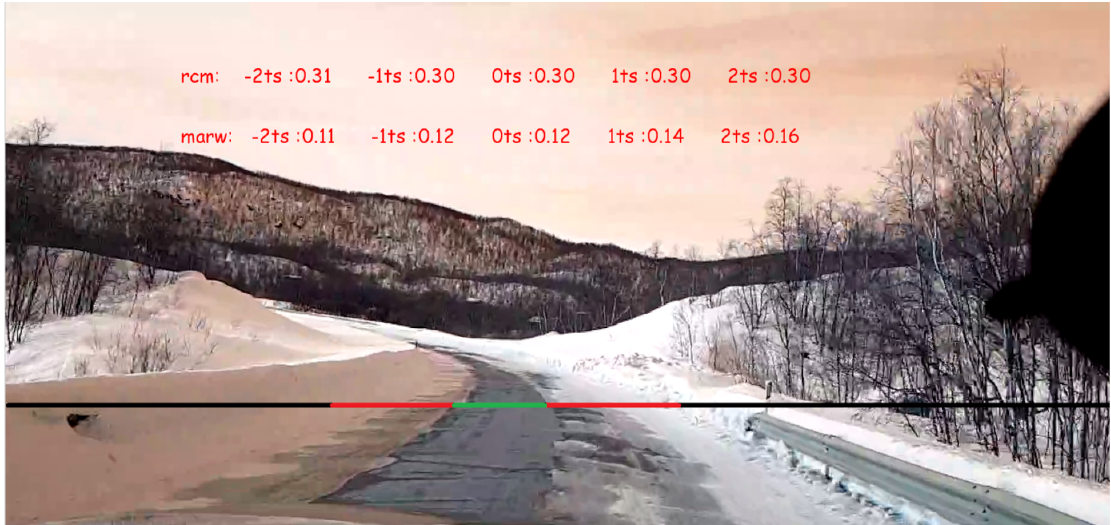
Figure 10. Example image on how video can be preprocessed using AI to estimate road conditions. Figure by Kristoffer